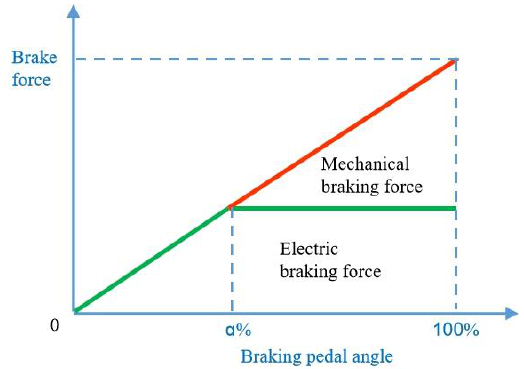
Figure 3. Relationship between the braking force and the brake pedal angle.